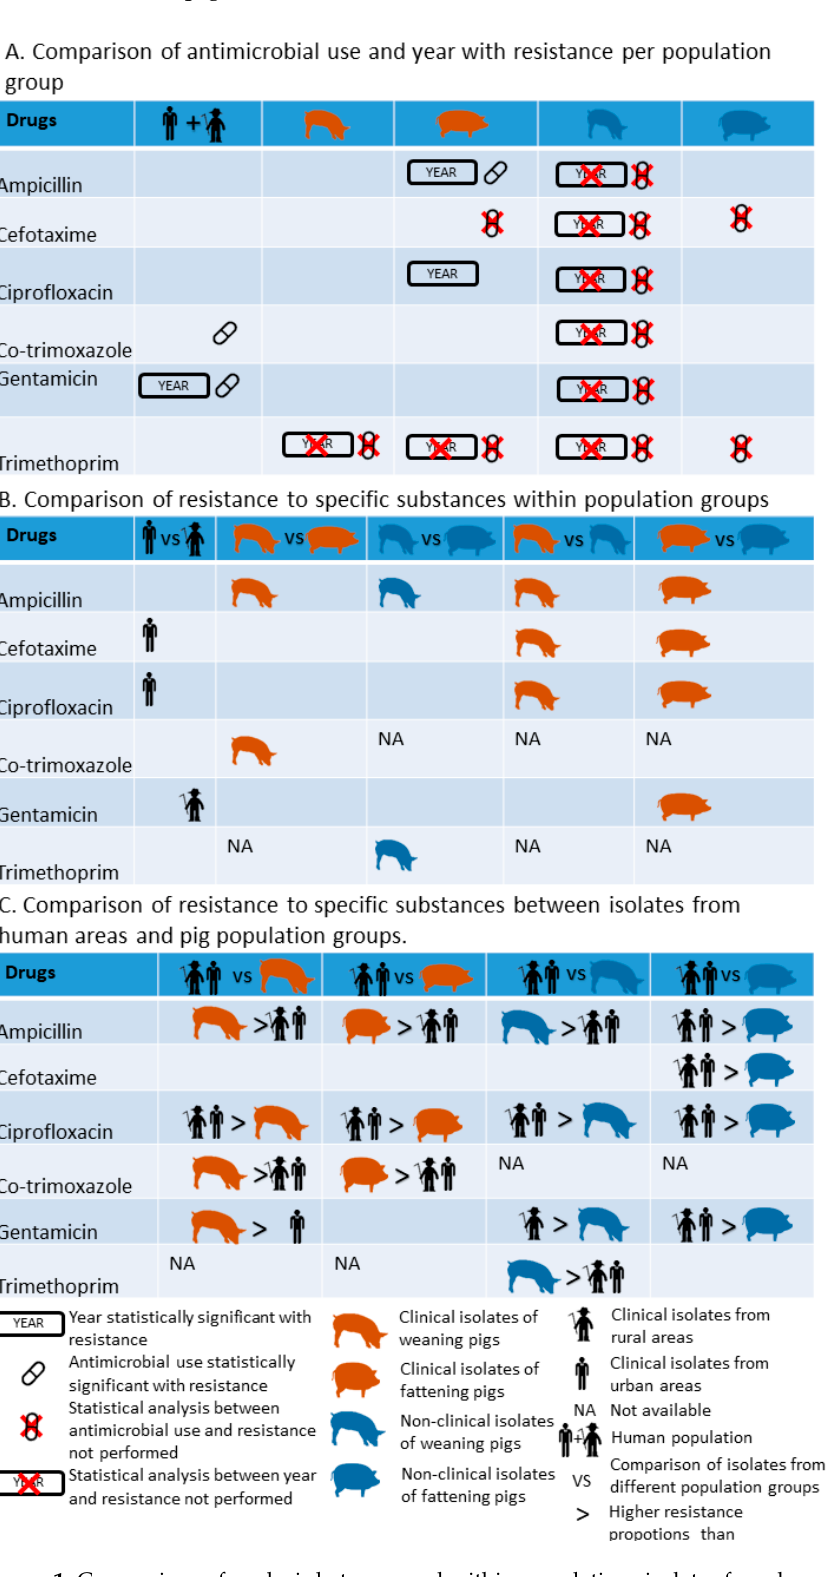
Figure 1. Comparison of analysis between and within populations isolates from humans and pigs.